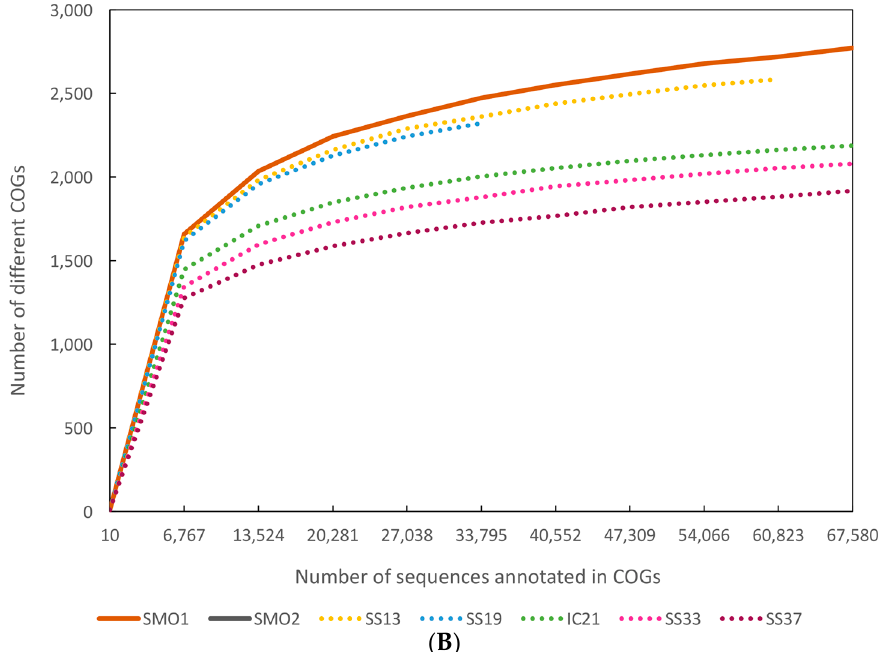
Figure 2. Rarefaction curves-based of the phylogenetic and metabolic prokaryotic diversity of the studied databases; ( A ) Rarefaction plot of the phylogenetic diversity, using Chao 1 index as alpha diversity metric; ( B ) Rarefaction plot of the functional diversity. Databases used are described in Table 1. COGs: Clusters of orthologous groups.